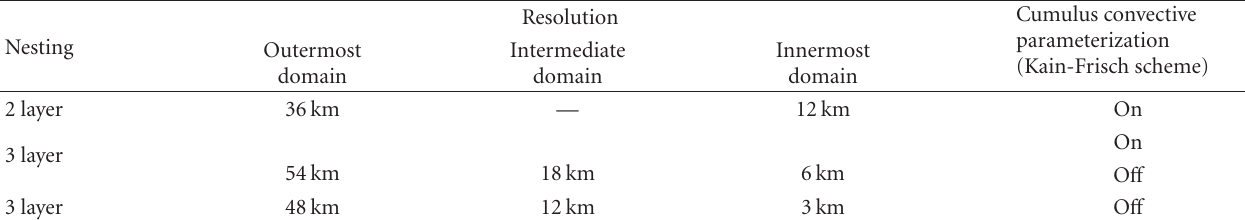
Table 1: A summary of the horizontal resolution and arrangement of nesting for four sets of simulations performed in this study. Also indicated in the table is whether cumulus parameterization is turned on or o ff .